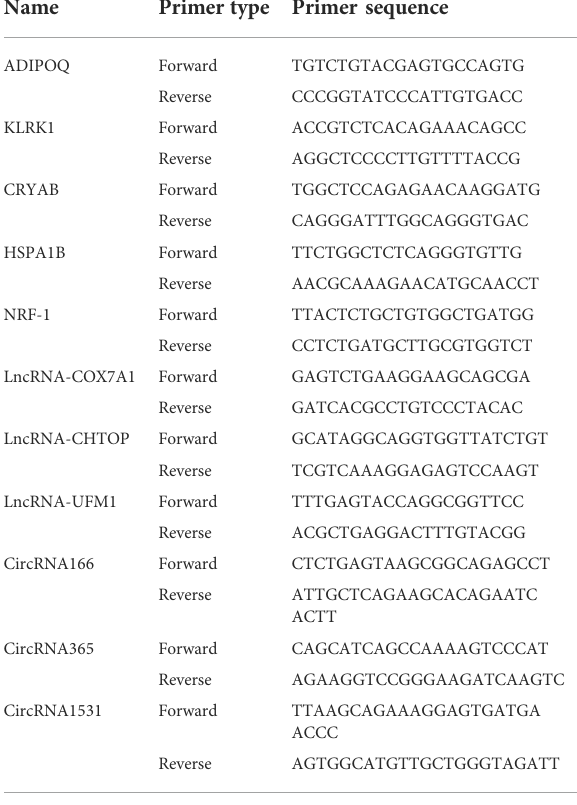
TABLE 1 Primer sequences for RT-qPCR analysis of differentially expressed mRNA, lncRNA and circRNA levels.